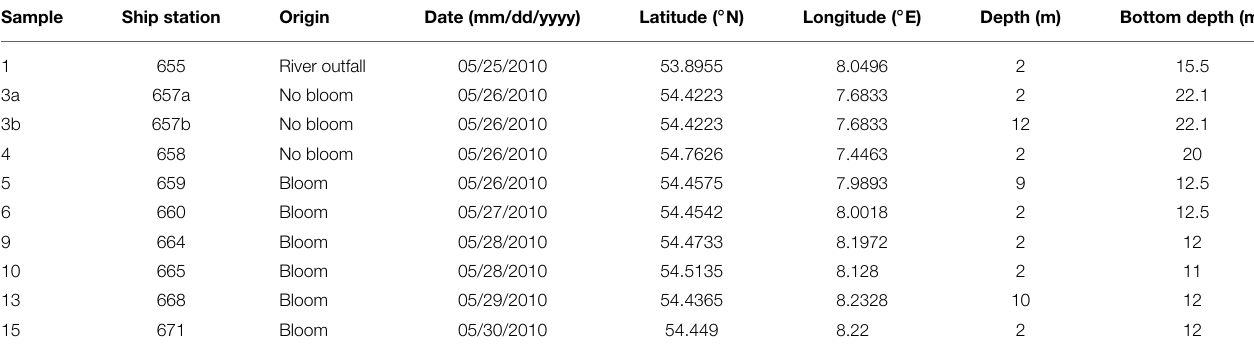
TABLE 1 | Sampling site